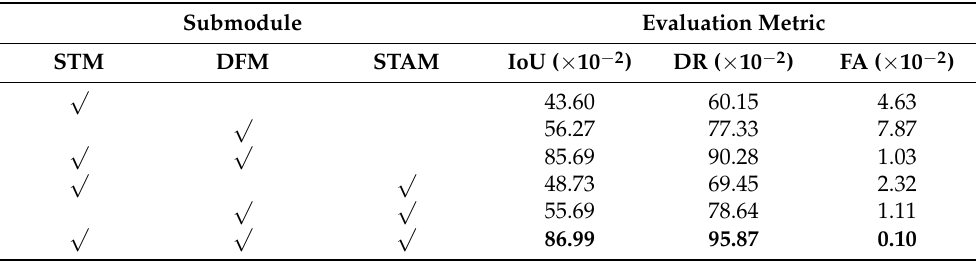
Table 5. Ablation studies on the components of our method. The self-made dataset is taken as a sample.